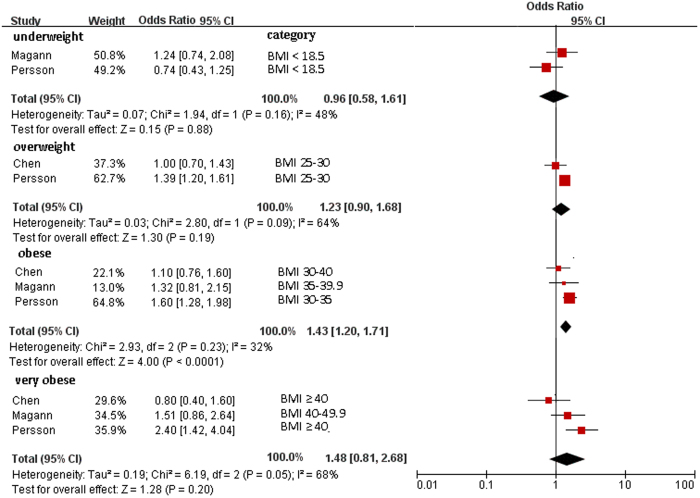
Forest plot of pooled analyses of maternal BMI categories and an Apgar score <3 at 5 minute.Maternal obesity by BMI categories was significantly associated with Apgar score <3. Maternal underweight, overweight, and very obesity categories showed nonsignificant trends toward increased an Apgar score <3. Note that ORs are for each category as compared with different reference category (Chen et al., BMI < 25; Magann et al., BMI 18–25; Persson et al., BMI 18.5–34.9).